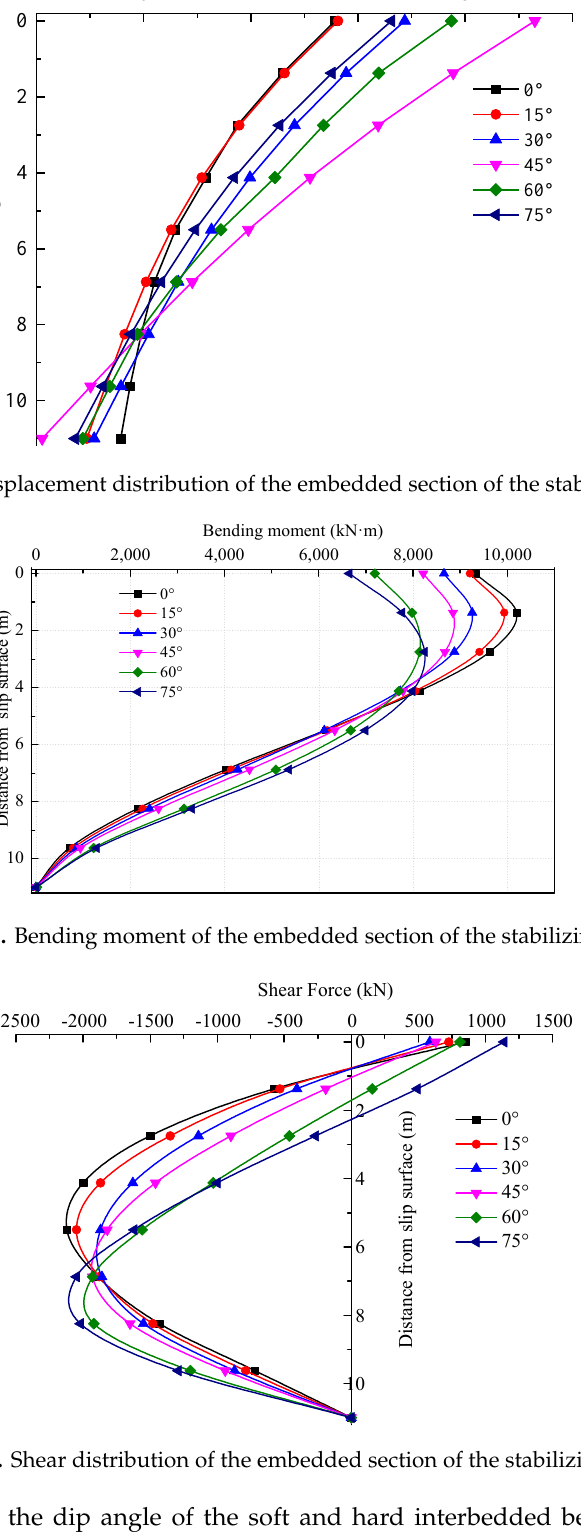
Figure 22. Shear distribution of the embedded section of the stabilizing pile.